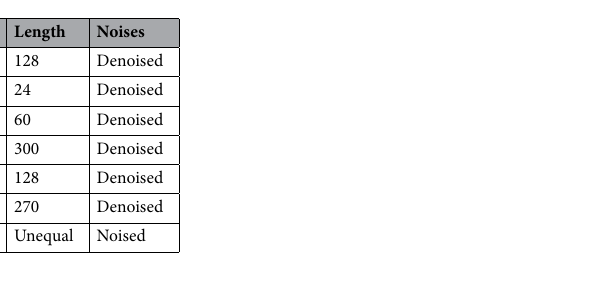
Table 2. The experiment data